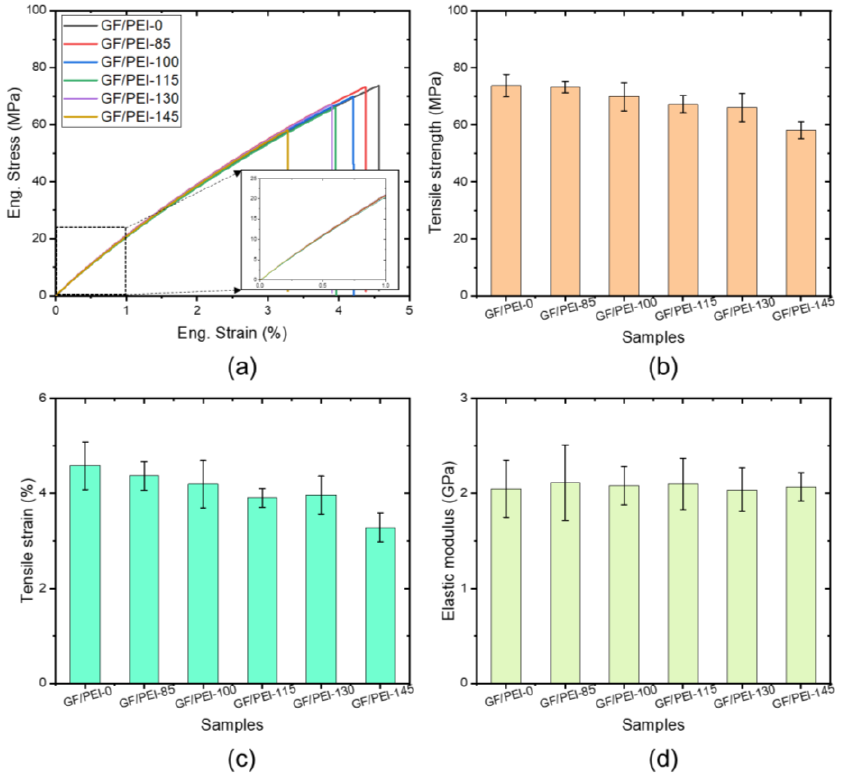
Figure 1. Typical tensile stress-strain curves of the aged specimens ( a ) and tensile strength ( b ), ten- sile strain ( c ) and elastic modulus ( d ) as a function of temperature. strain ( c ) and elastic modulus ( d ) as a function of